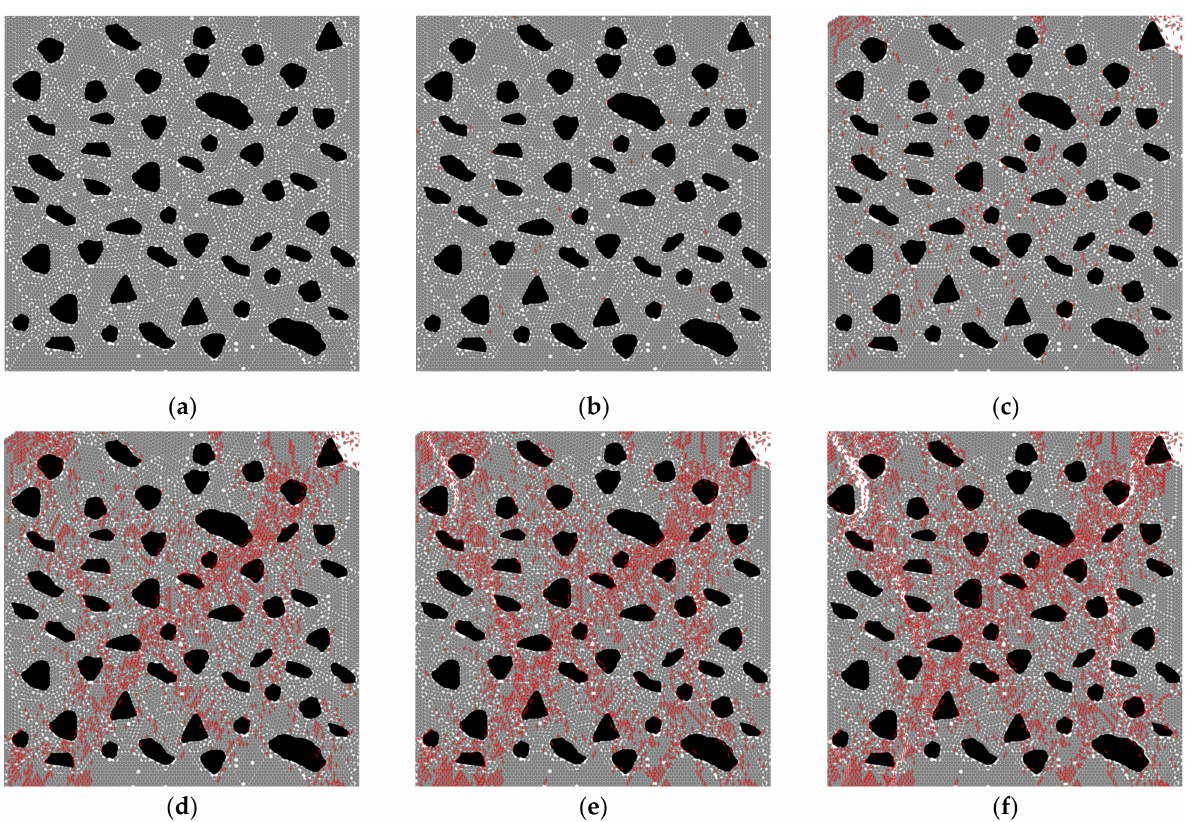
Figure 11. Simulation of the damage process in concrete specimens. (Load percentage: ( a ) 0%, ( b ) 57.5%, ( c ) 65.0%, ( d ) 83.5%, ( e ) 92.8%, ( f )